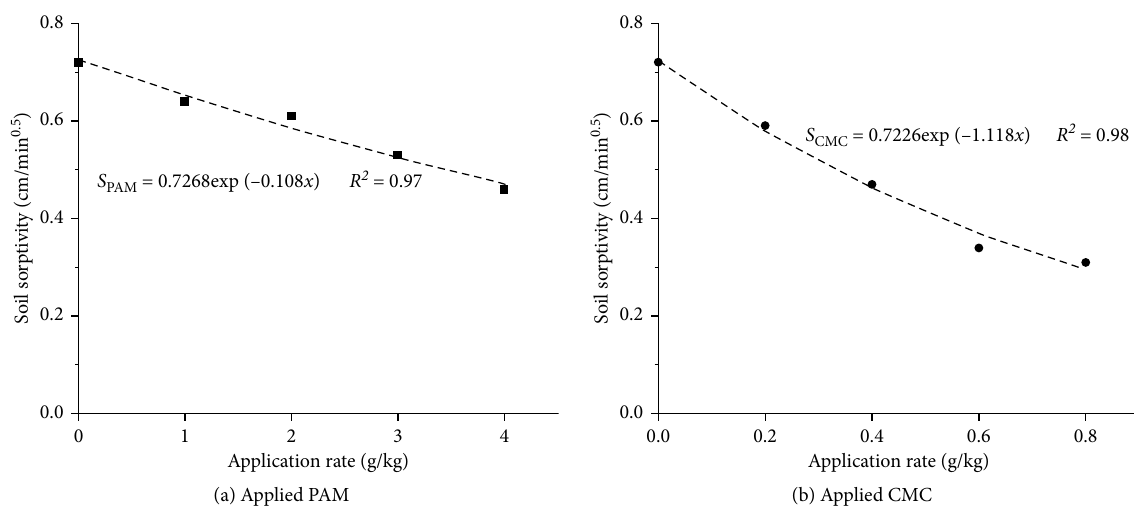
Figure 3: Effects of different application rates for (a) PAM and (b) CMC on soil sorptivity in sandy loam soils.